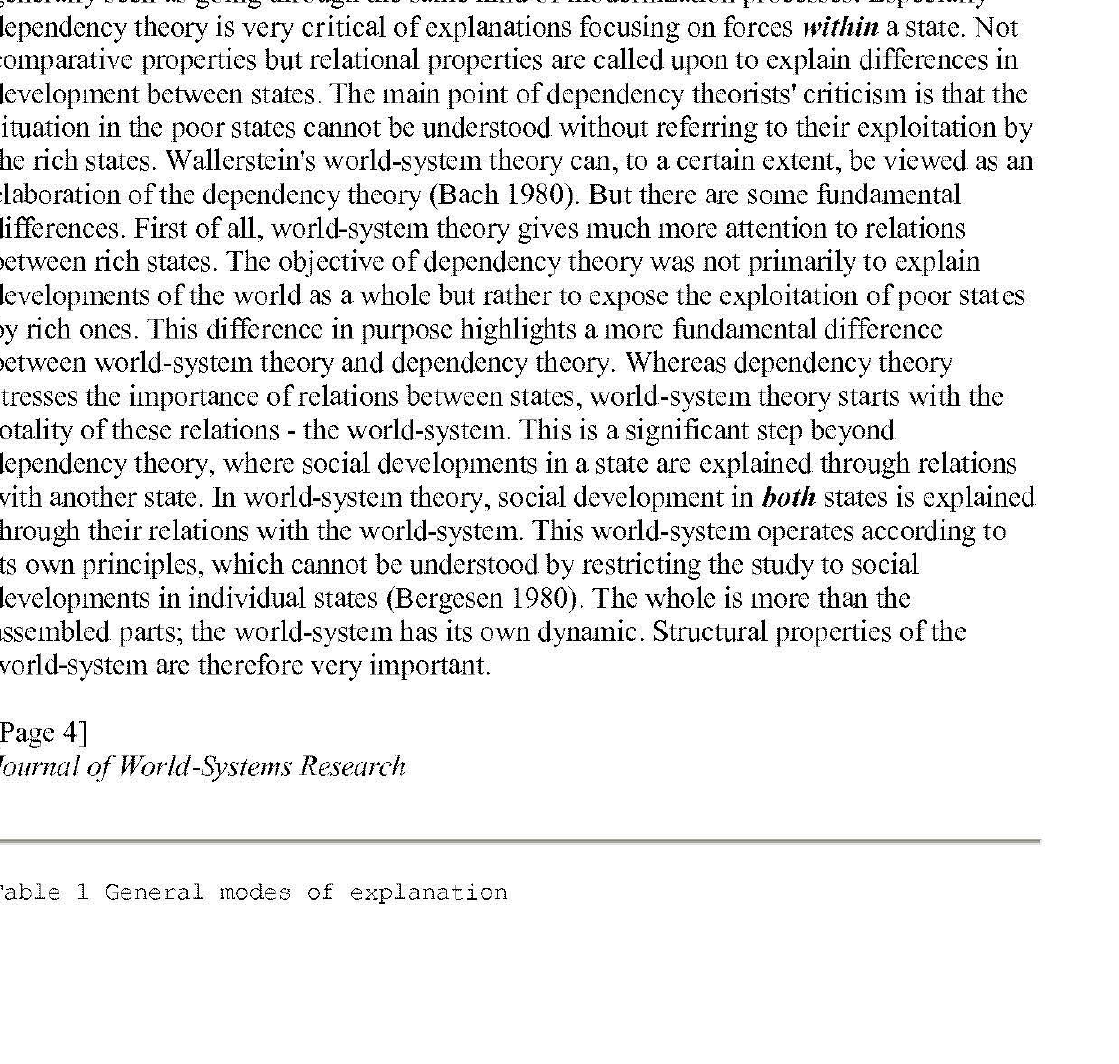
1 Gene r al modes of explana t